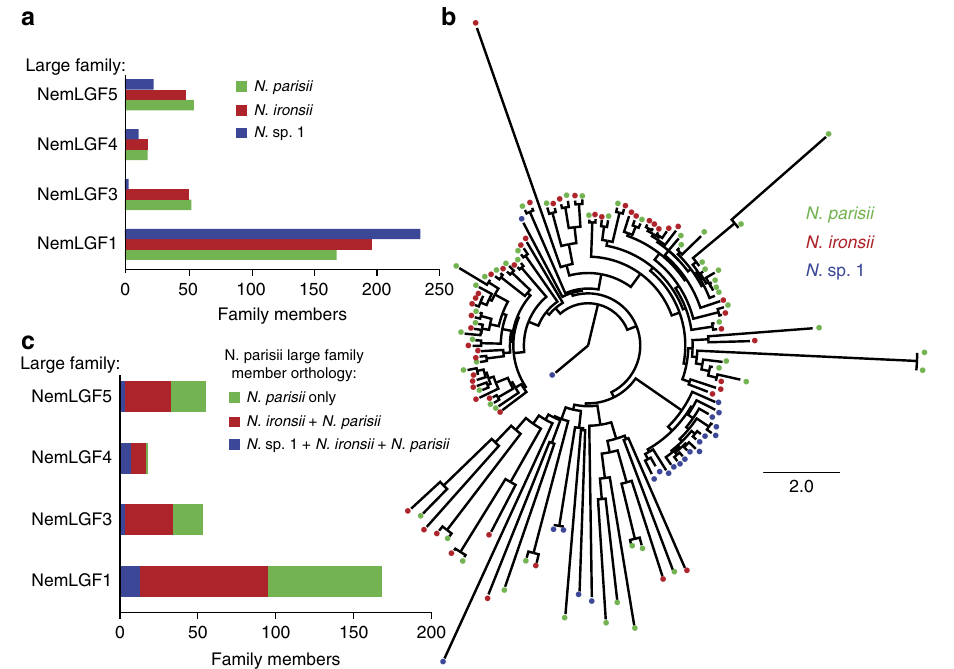
Figure 3 | Species-specific radiation of large gene family members. ( a ) Number of members for each gene family that are present in each species. ( b ) NemLGF5 tree showing gene family-specific radiation. Scale is changes per site. ( c ) The number of proteins for the indicated gene family that are either unique to N. parisii (green), have orthologs in N. ironsii (red) or have orthologs in N. sp. 1 and N. ironsii